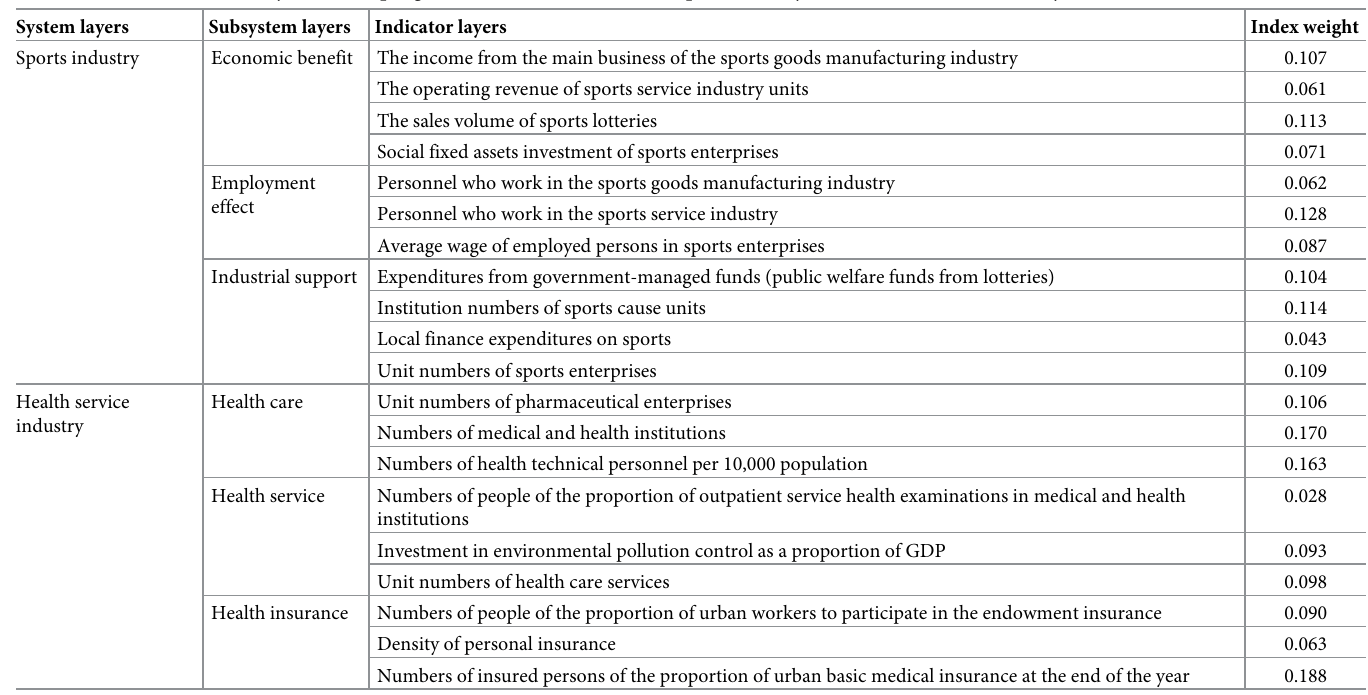
Table 2. The evaluation index system of coupling and coordination between the sports industry and the health service industry. System layers Subsystem layers Indicator